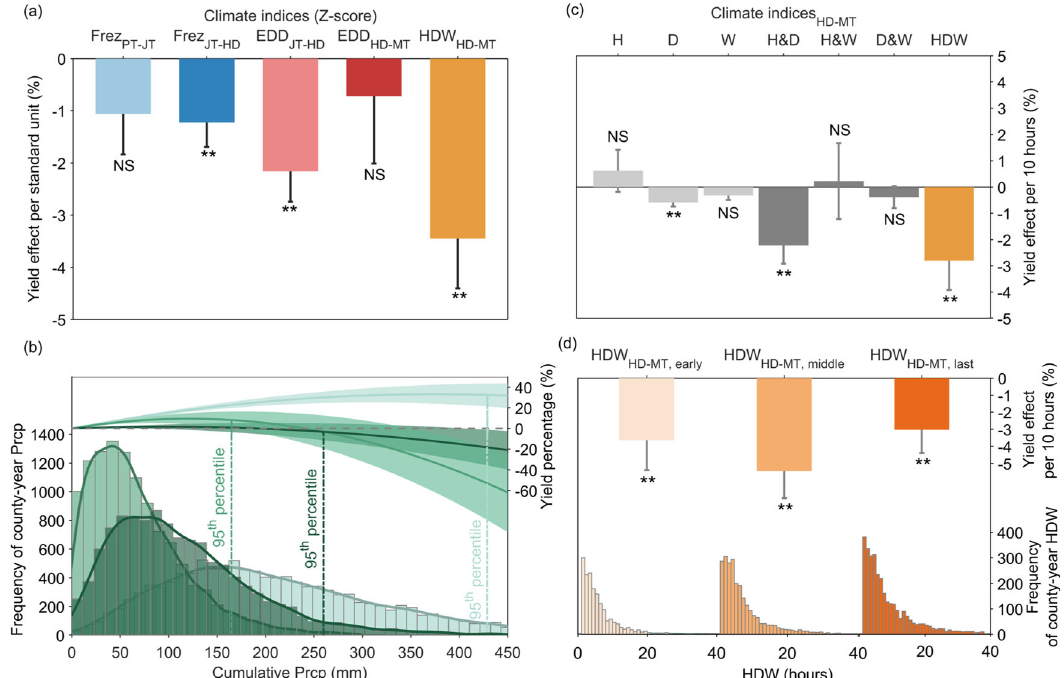
Fig. 2 | Estimated effects of climate indices on winter wheat yields relative to the average yield. a The yield effects are expressed as a percent of area-weighted averageyield(grandaverage=2.4tha − 1 )acrossourstudydomainperstandardunit of climateindices(SupplementaryTable 2).Onestandardunitof climateindicesin their distributions across the studydomain is 14.77days for Frez PT-JT , 0.89days for Frez JT-HD ,0.35°CdaysforEDD JT-HD ,2.81°CdaysforEDD HD-MT ,and9.03hforHDW. Frezstandsforfreezing;EDDstandsforextreme degreedays;HDWstandsforhot- dry-windy events. PT-JT is the planting to jointing stage; JT-HD is the jointing to heading stage; HD-MT is the heading to maturity stage. b The percent change in yield as a function of the cumulative precipitation (Prcp) by growth stages. The